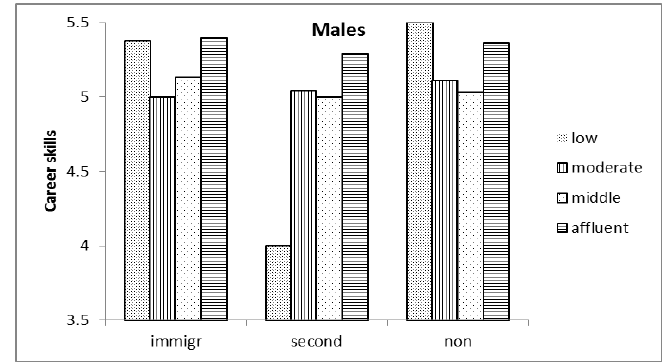
Figure 2. Occupational expectations by immigration history, parent income, and sex of